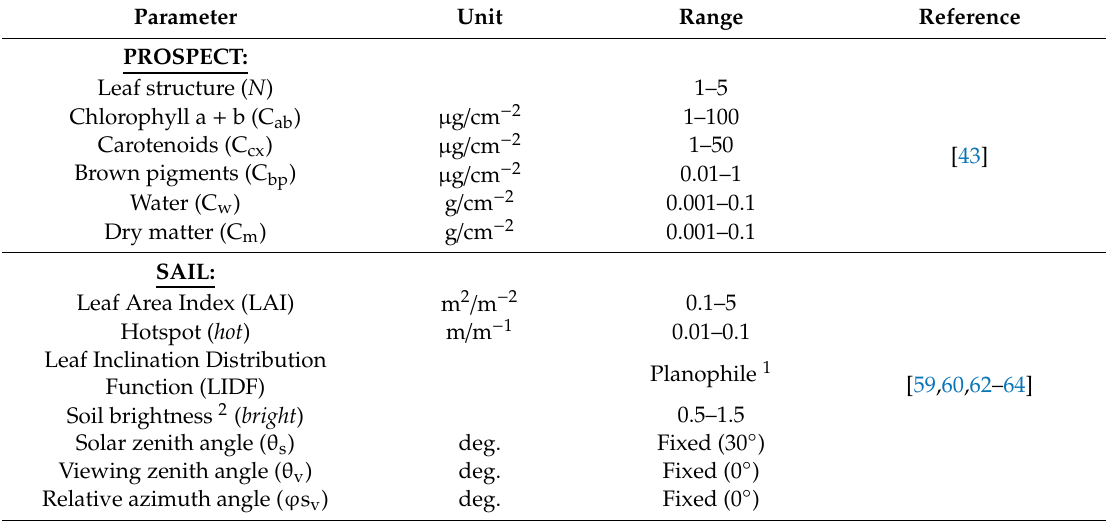
di ff erential evolution algorithm [43,61] and the model parameters listed in Table 2. The LCC values retrieved from canopy measurements and from the image were compared to those of leaves using the R 2 and the root mean square error (RMSE) [43]. Table 2. Parameter bounds used to compute PROSPECT and PROSAIL (PROSPECT + SAIL)